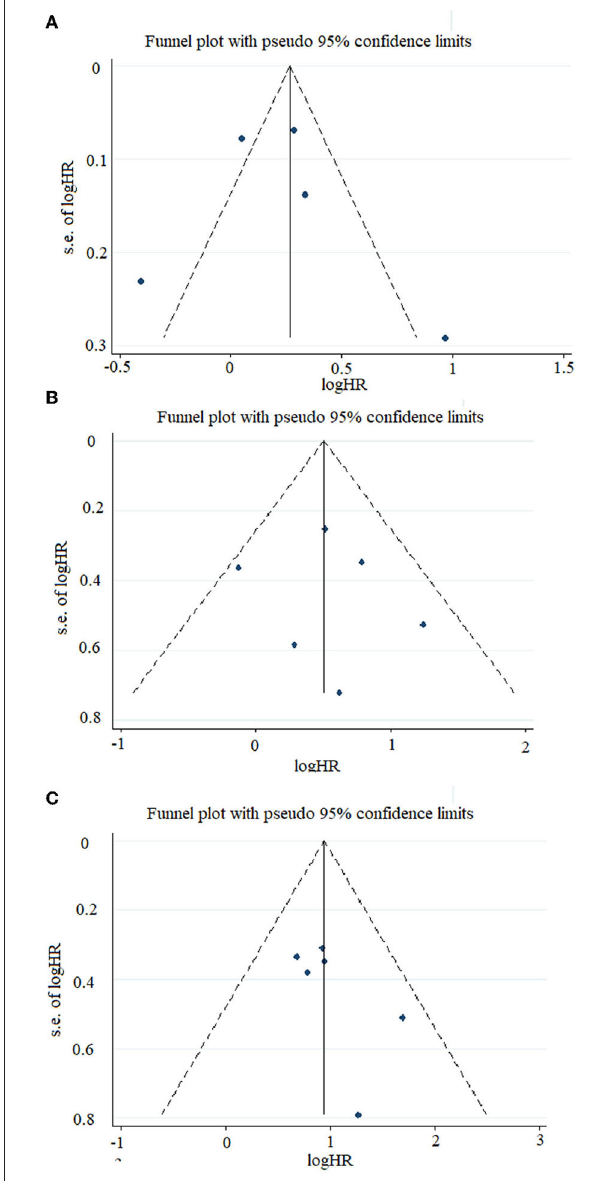
FIGURE 4 | Funnel plots of the studies included in this meta-analysis. (A) Included studies related to TAZ expression and overall survival in the overall population. (B) Included studies related to YAP expression and disease-free survival in the overall population. (C) Included studies related to YAP expression and overall survival in the overall